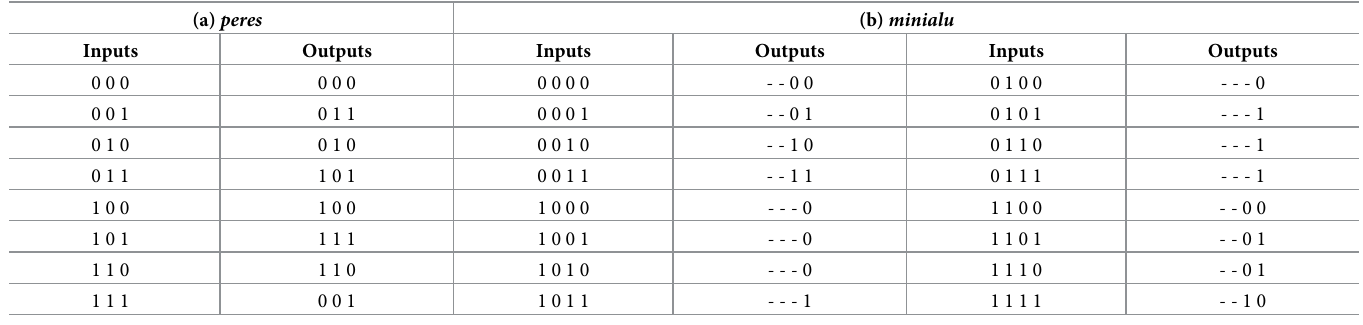
(a) Completely specified function peres (b) Incompletely specified function